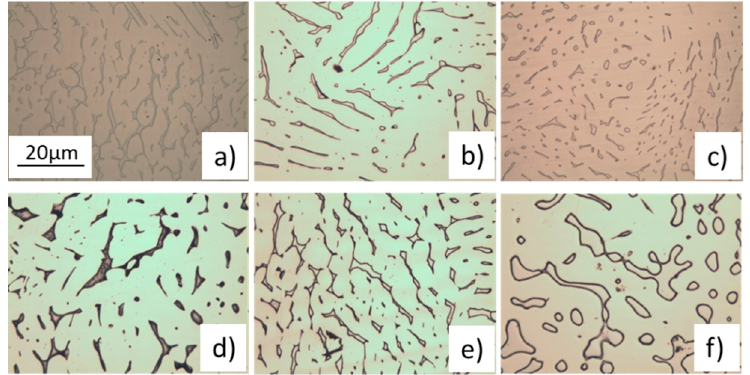
Figure 3. Micrographs of the cast stainless steel, which were heat treated at different temperatures for 8 h ( a ) at 1030 °C, ( b ) at 1080 °C, ( c ) at 1130 °C, ( d ) at 1180 °C, ( e ) at 1230 °C, and ( f ) at 1280 °C. for 8 h ( a ) at 1030 ◦ C, ( b ) at 1080 ◦ C, ( c ) at 1130 ◦ C, ( d ) at 1180 ◦ C, ( e ) at 1230 ◦ C, and ( f ) at 1280 ◦ C.